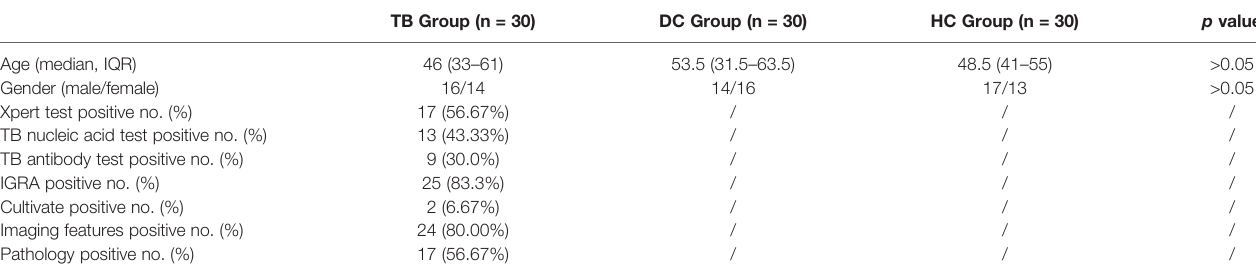
TABLE 1 | Clinical information of the study